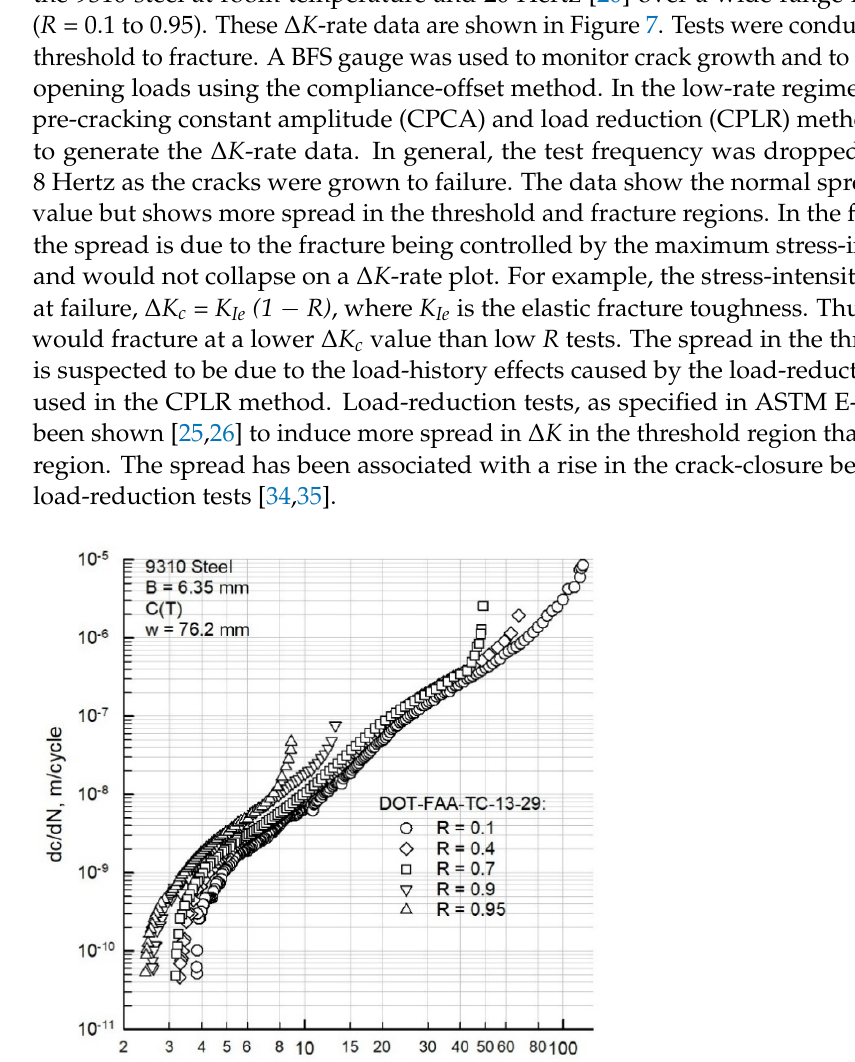
were used to calculate K Ie (elastic stress-intensity factor at failure), and these results are